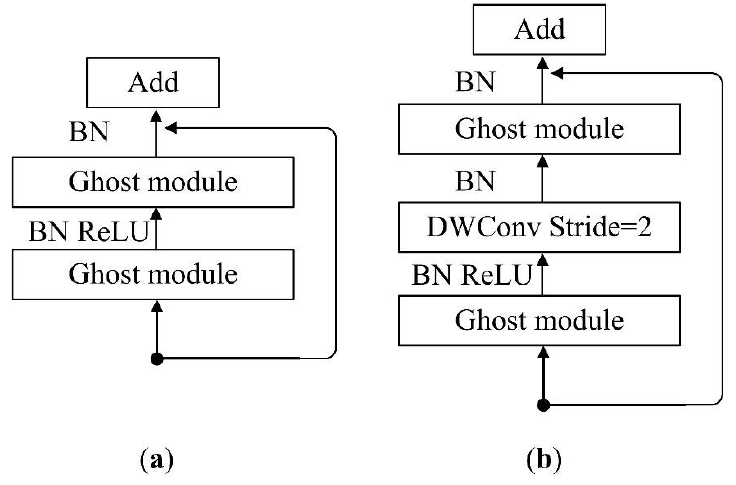
Figure 5. Ghost Bottleneck with stride = 1 ( a ) and 2 ( b ).